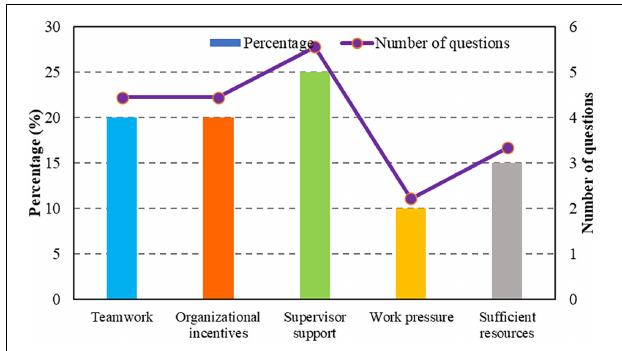
FIGURE 5 | Factor analysis of enterprise work environment scale.